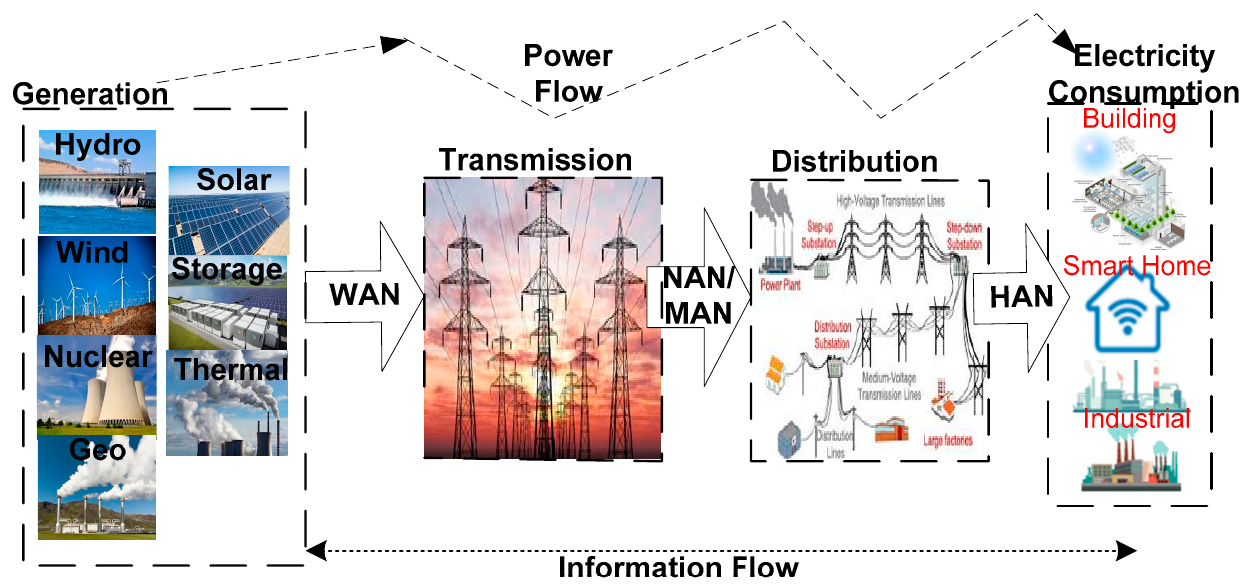
Figure 7. Architecture presenting power system, information flow, and power flow [117].